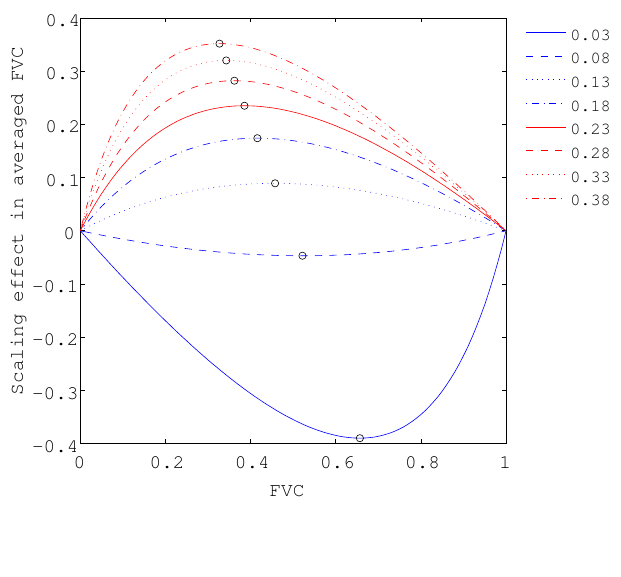
Figure 10. Numerical demonstration of ω were computed over the domain of true FVC values (from zero to unity) using the eight endmember sets listed in Table 4. The non-vegetation endmember spectrum was varied over the red reflectance range from 0.03 to 0.38 in increments of 0.05, and the slope of the soil line was assumed to be 1.2. The red reflectance in the non-vegetation endmember are identified based on the colors and lines. The variables ω results and are denoted by empty